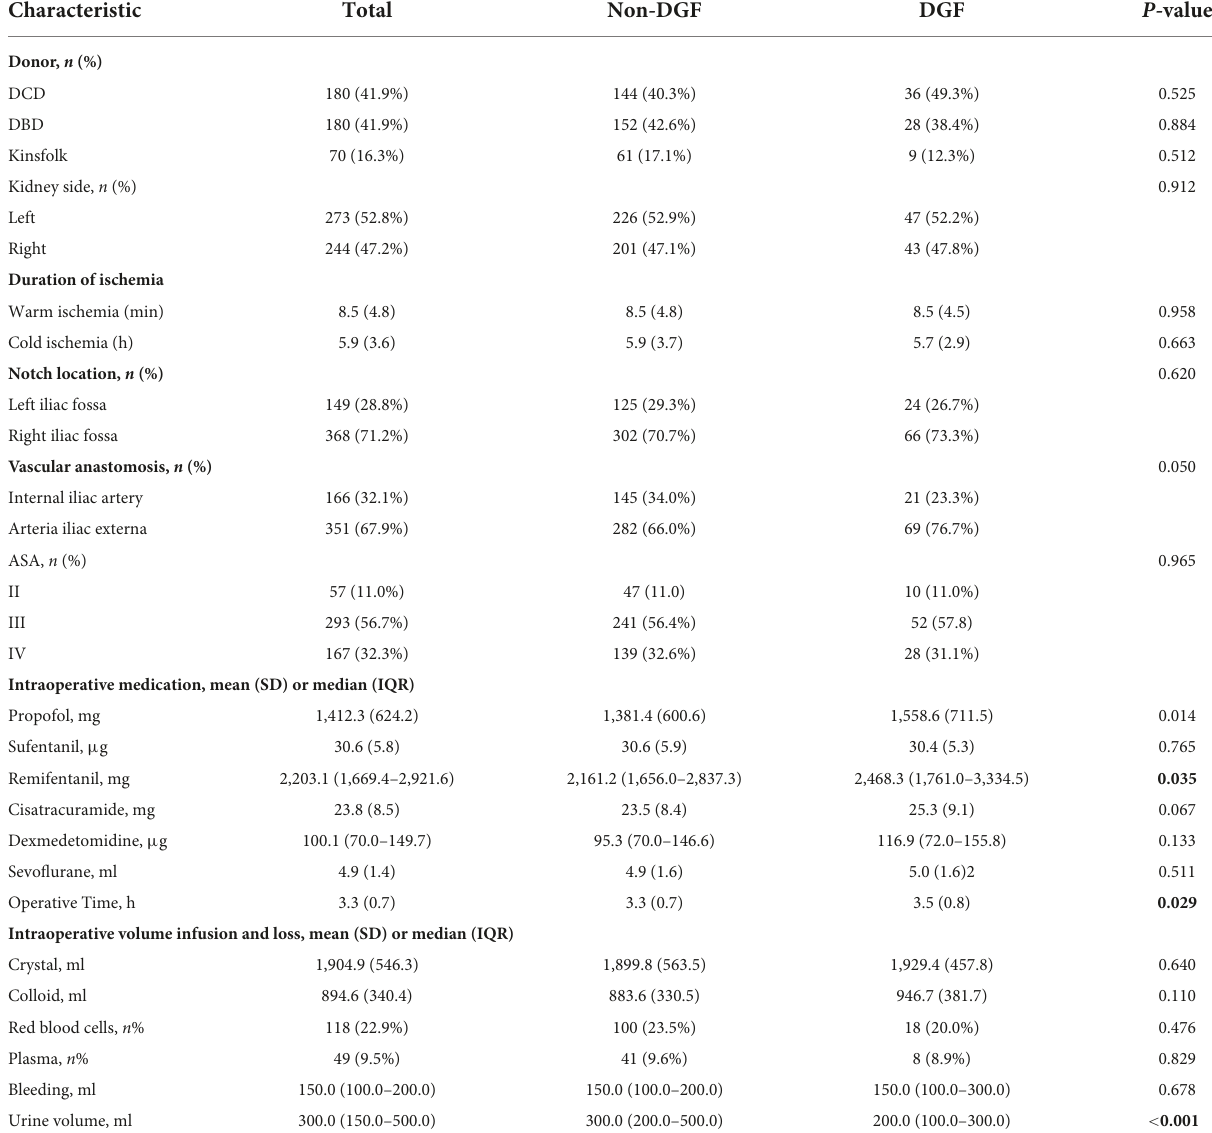
TABLE 2 Surgical information is presented as mean (SD), median (IQR) or number